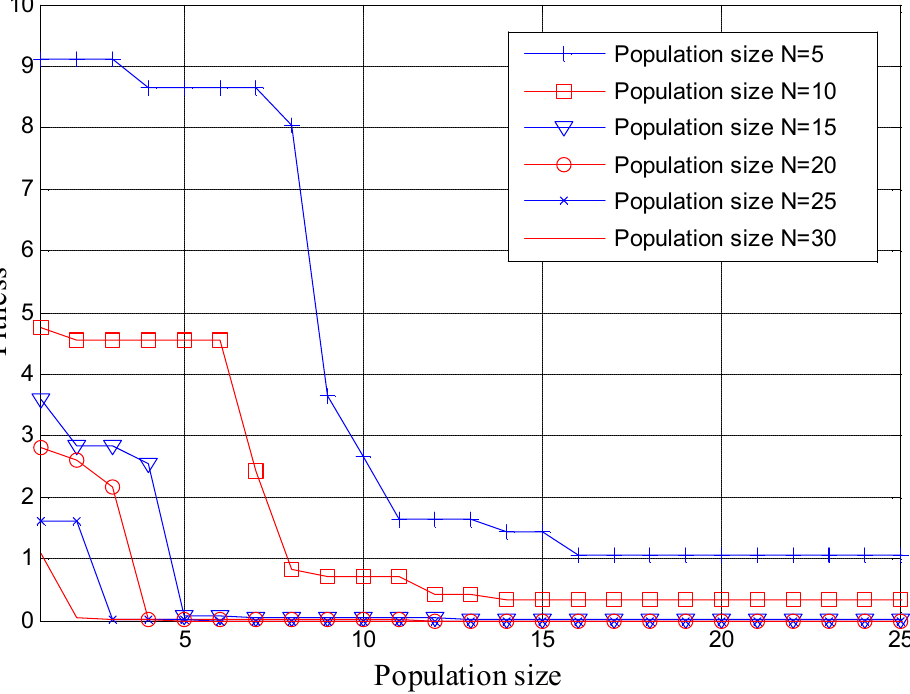
Figure 7. Effect of population size on fitness.